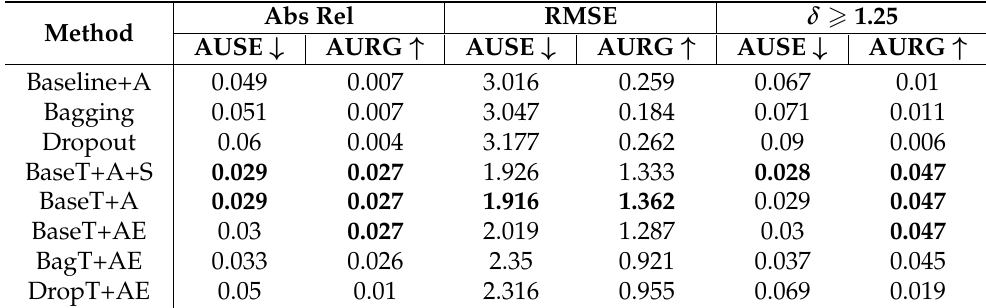
Table 5. Quantitative results of our different strategies for uncertainty evaluation on KITTI new benchmark [61]. The best results in each metric are shown in